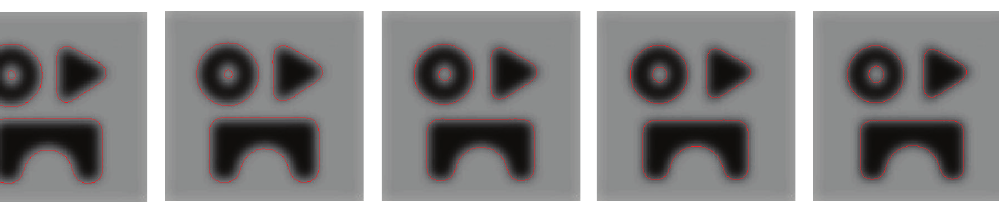
to denote patterns with large extent of vagueness and to elevate or reduce membership degrees in other